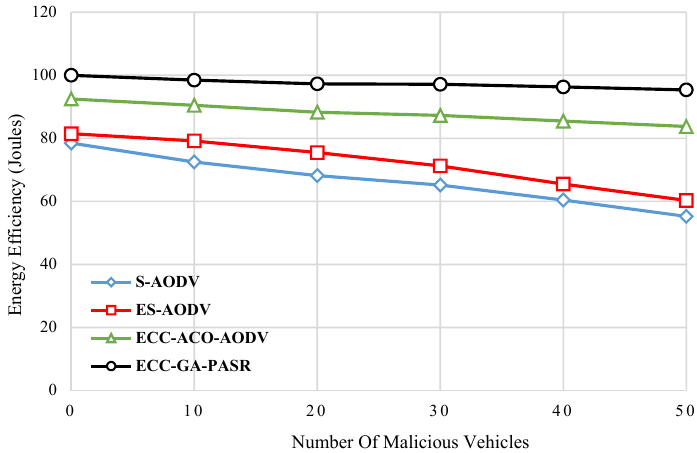
Figure 17. Energy Efficiency Calculation based on number of malicious vehicles.